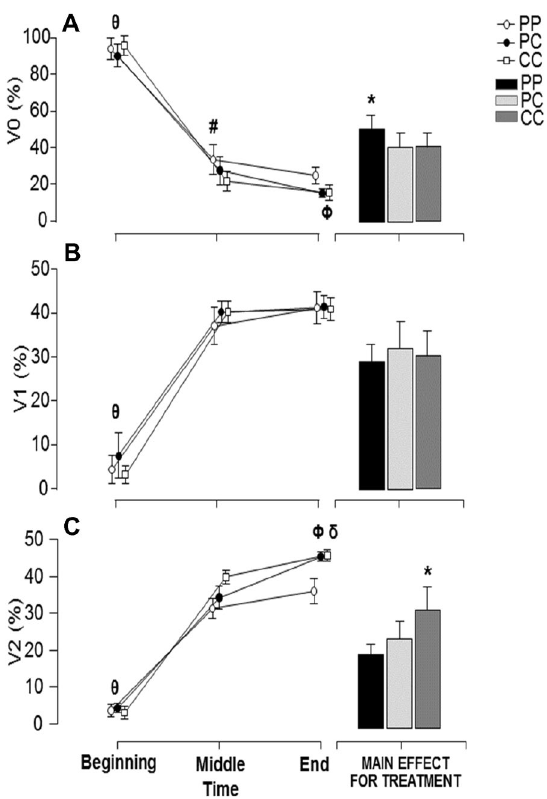
Figure 3. ( A ) Mean ± SE of V0 (%) at the beginning, midway and final of exercise protocol with 3 experimental conditions: Placebo-Placebo (PP), Placebo-Caffeine (PC) and Caffeine-Caffeine (CC). (θ) Beggining was significantly different from midway and final of the exercise protocol in all experimental conditions; (Φ) Midway was significantly different from final of the exercise protocol in PC experimental conditions ( P < 0.05); (#) Significantly difference between CC and PP experimental conditions at the midway of the exercise protocol ( P < 0.05); (*) Significantly different from other experimental conditions ( P < 0.05). ( B ) Mean ± SE of V1 (%) at the beginning, midway and final of exercise protocol with 3 experimental conditions: Placebo–Placebo (PP), Placebo–Caffeine (PC) and Caffeine–Caffeine (CC). (θ) Beggining was significantly different from midway and final of the exercise protocol in all experimental conditions ( P < 0.05). ( C ) Mean ± SE of V2 (%) at the beginning, midway and final of exercise protocol with 3 experimental conditions: Placebo–Placebo (PP), Placebo–Caffeine (PC) and Caffeine–Caffeine (CC). (θ) Beggining was significantly different from midway and final of the exercise protocol in all experimental conditions ( P < 0.05); (Φ) Midway was significantly different from final of the exercise protocol in PC experimental conditions ( P < 0.05); (δ) Significantly difference among PP and both CC and PC experimental conditions at the final of the exercise protocol ( P < 0.05); (*) Significantly different from other experimental conditions ( P <